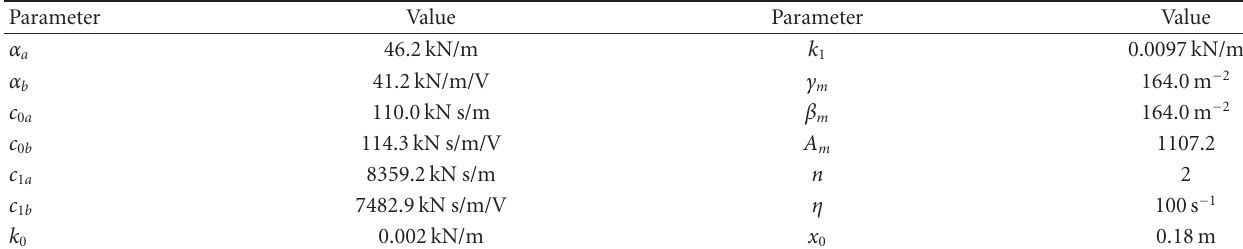
Table 2: Parameters for the MR damper model (200kN capacity)